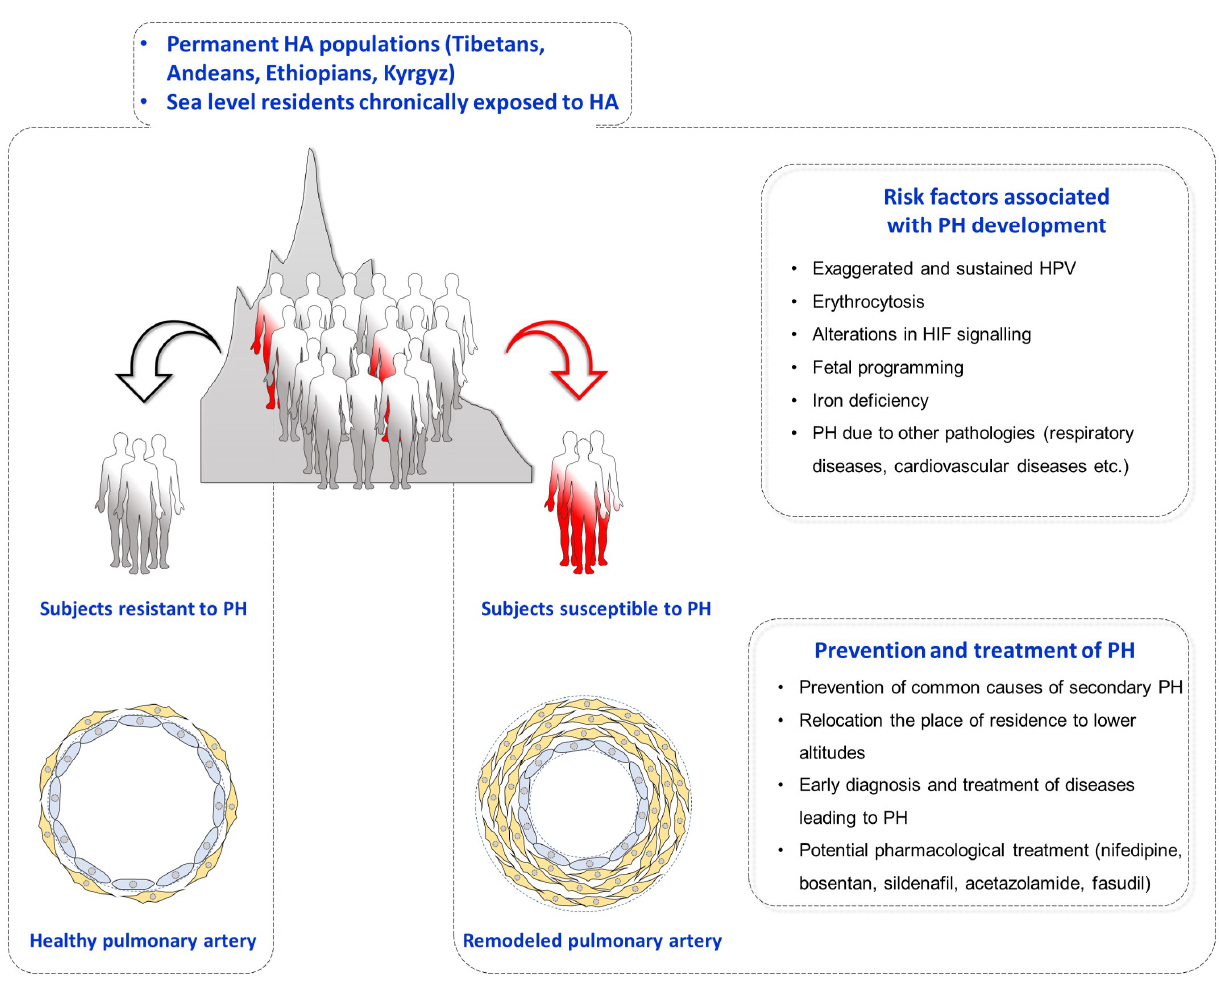
Figure 4. Pulmonary hypertension in high altitude residents. Populations permanently living at high altitude (HA)—such as Tibetans, Andeans, Ethiopians, and Kyrgyz—and sea level residents chronically exposed to HA are at risk for the development of pulmonary hypertension (PH). In addition to chronic alveolar hypoxia, susceptibility to develop PH at HA can be increased by several factors, such as exaggerated and sustained hypoxic pulmonary vasoconstriction (HPV), erythrocytosis, altered HIF signaling, fetal programming, iron deficiency, and due to other respiratory and cardiovascular diseases. Several strategies have been suggested to prevent and treat PH at HA, including prevention of common causes of secondary PH, relocation the place of residence to lower altitude, early diagnosis and treatment of diseases leading in PH, and application of potential pharmacological treatment (nifedipine, bosentan, sildenafil, acetazolamide, and